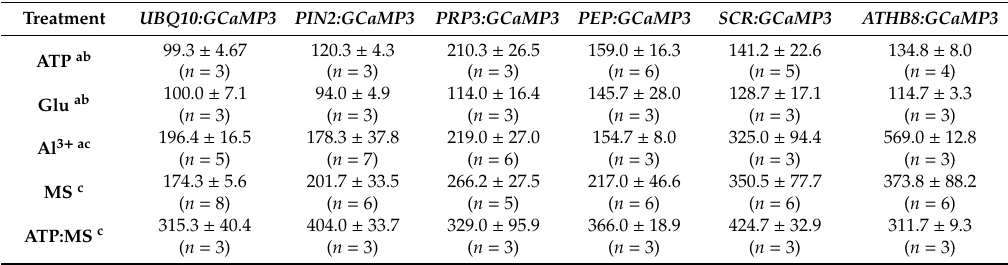
Table 1. Reaction time analysis of [Ca 2 + ] cyt response where reaction time is the time elapsed from chemical application to maximum GCaMP3 fluorescence (reaction time ± SE; n = sample size; reaction time is in seconds). Statistical analysis using Analysis of Variance (ANOVA) with Tukey Post-Hoc test ( p ≤ 0.05 for reported significance) was performed for di ff erences in chemical treatments only due to the lack of comparable ROI sections between cell-type lines. Due to limited sample size, significance may indicateageneraltrendratherthanactualsignificance. ATP = adenosinetri-phosphate; Glu =